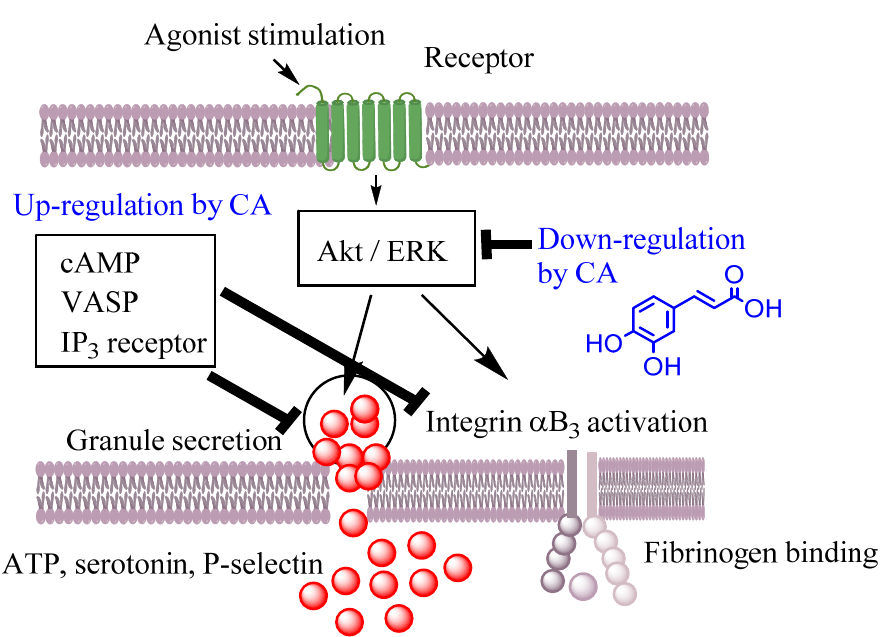
Figure 16. Effects of caffeic acid (CA) on platelet activation in thrombin-simulated platelets (adapted from [148]). Caffeic acid may act as a potential therapeutic compound by inhibiting thrombin-induced platelet aggregation, adenosine 1,4,5-tri-phosphate (ATP) release, the phosphorylations of protein kinase B (AKt) and extracellular signal-regulated kinase (ERK). Moreover, CA may also improve cyclic adenosine monophosphate (cAMP) production, which may induce the phosphorylation of the vasodilator-stimulated phosphoprotein (VASP) and inositol trisphosphate (IP3) receptor. Reprinted from [148], Copyright (2022), with permission from Elsevier.